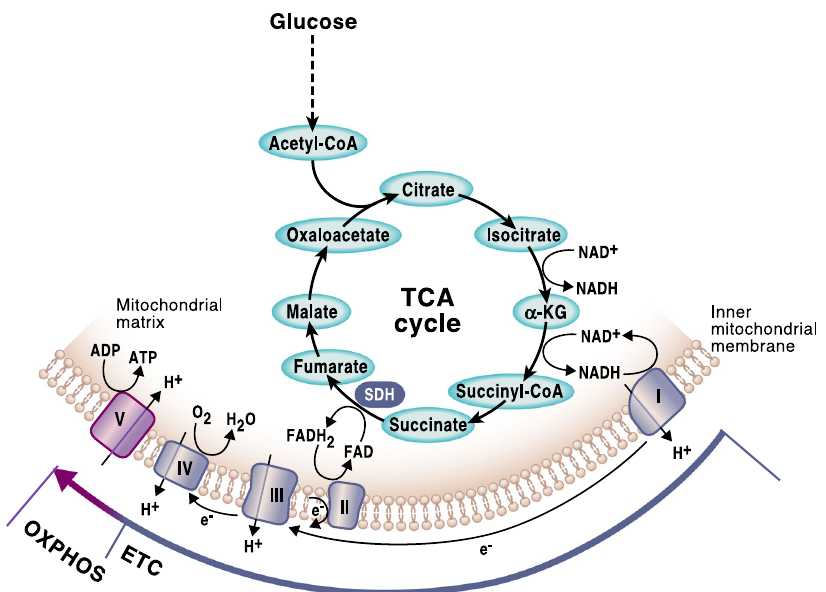
Fig. 3 The TCA cycle and OXPHOS are tightly coordinated. In a series of enzymatic reactions the TCA cycle generates the reducing equivalents NADH and FADH2, which are required to transfer electrons to the mitochondrial respiratory chain, also known as the electron transport chain (ETC). As the electrons are funneled through the complexes in the inner mitochondrial membrane, a functional ETC generates a mitochondrial membrane potential that is used to produce ATP. This process requires the presence of oxygen and it is known as oxidative phosphorylation (OXPHOS). Mitochondrial complex I and II in the ETC replenish NAD + and FAD, respectively, allowing the oxidative TCA cycle to function. Succinate dehydrogenase is the only enzyme that participates in both the TCA cycle and the